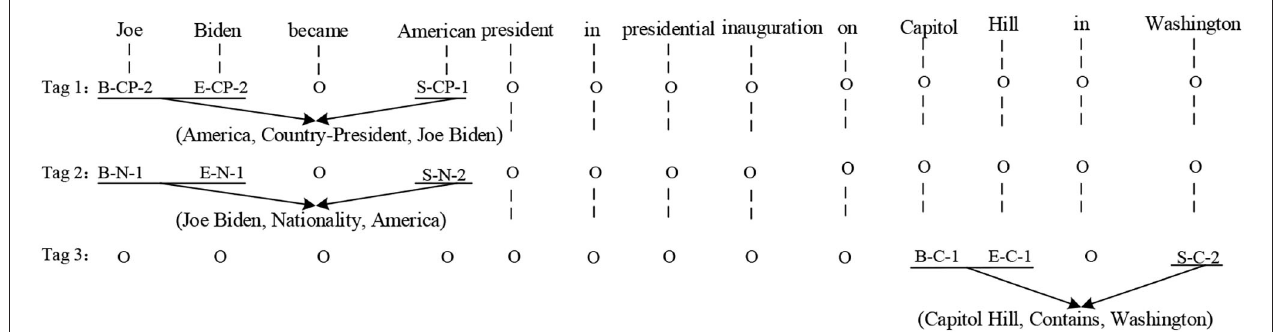
FIGURE 2 | An example of the tagging scheme.